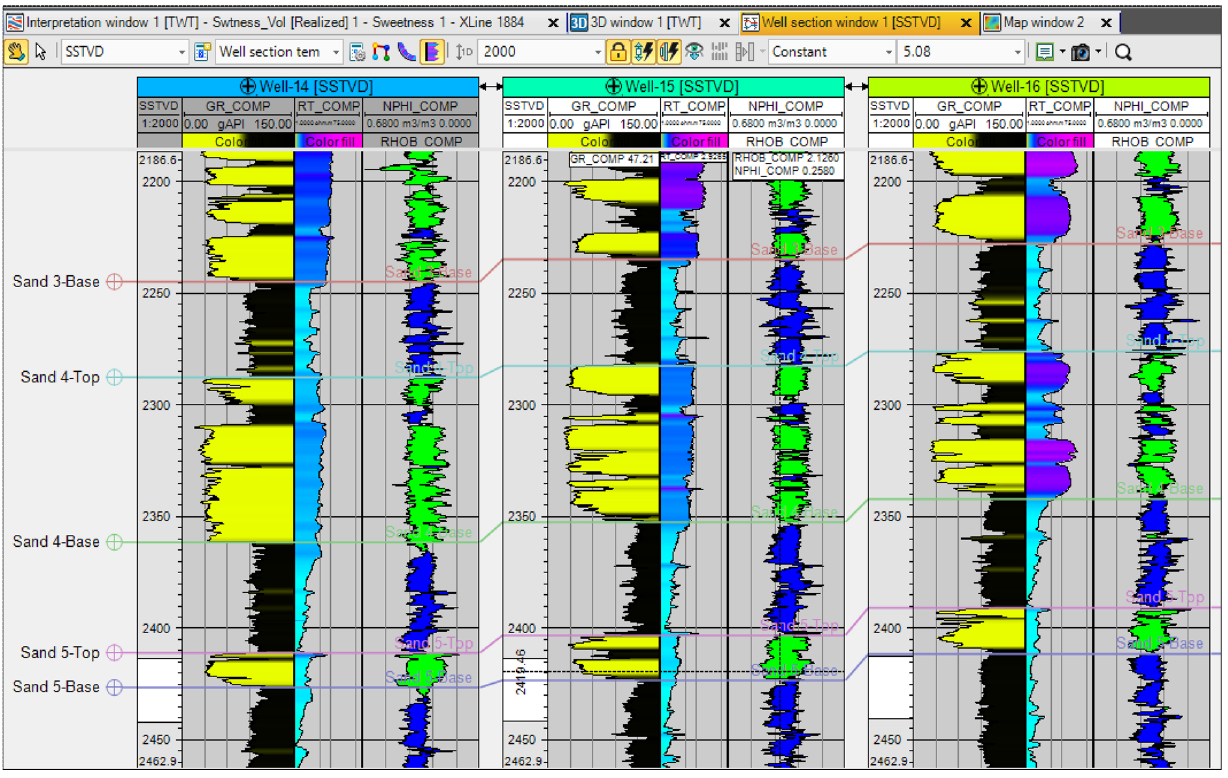
Fig. 6 Mapped reservoirs and well